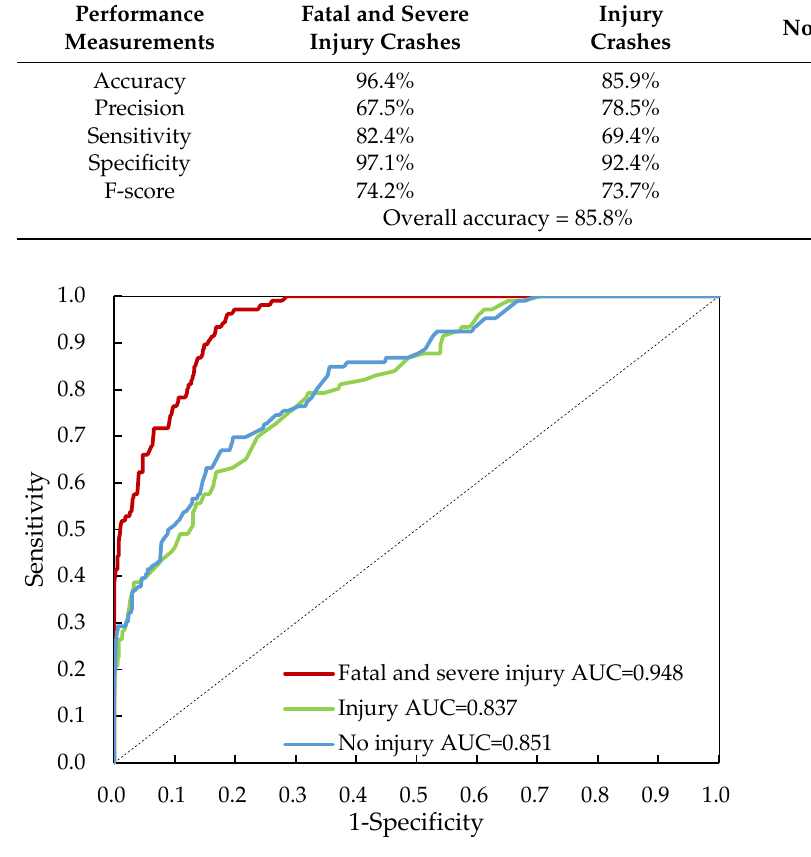
Figure 8. ROC curve for the Bayesian network model evaluation.